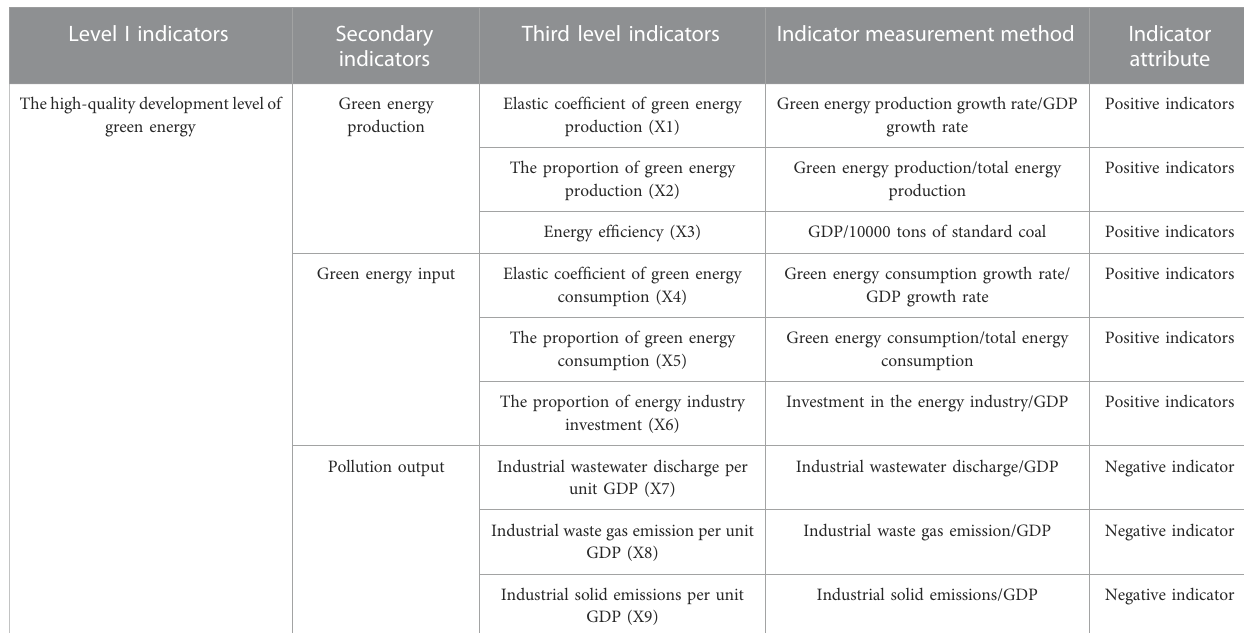
TABLE 1 Indicator system of high-quality development level of green